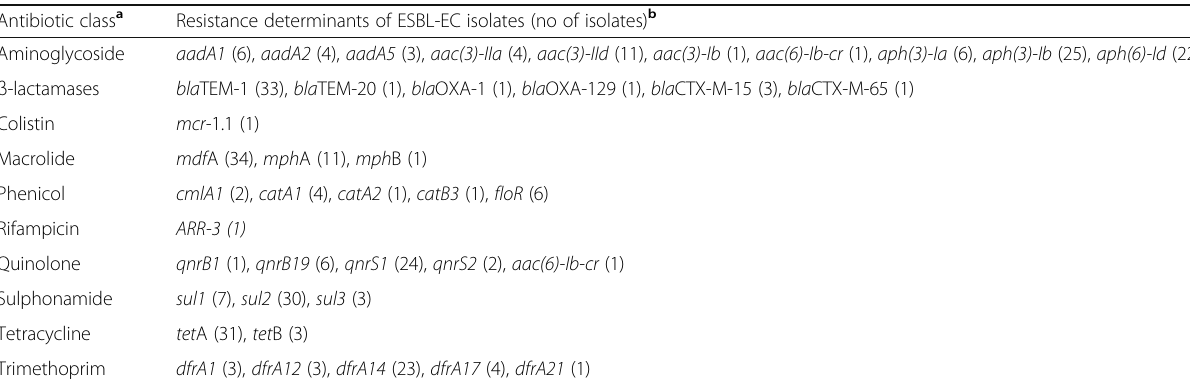
Table 2 Resistance determinants detected in ESBL-EC isolates from humans, chickens and farm/market environment in Abuja - Nigeria, 2019 Antibiotic class